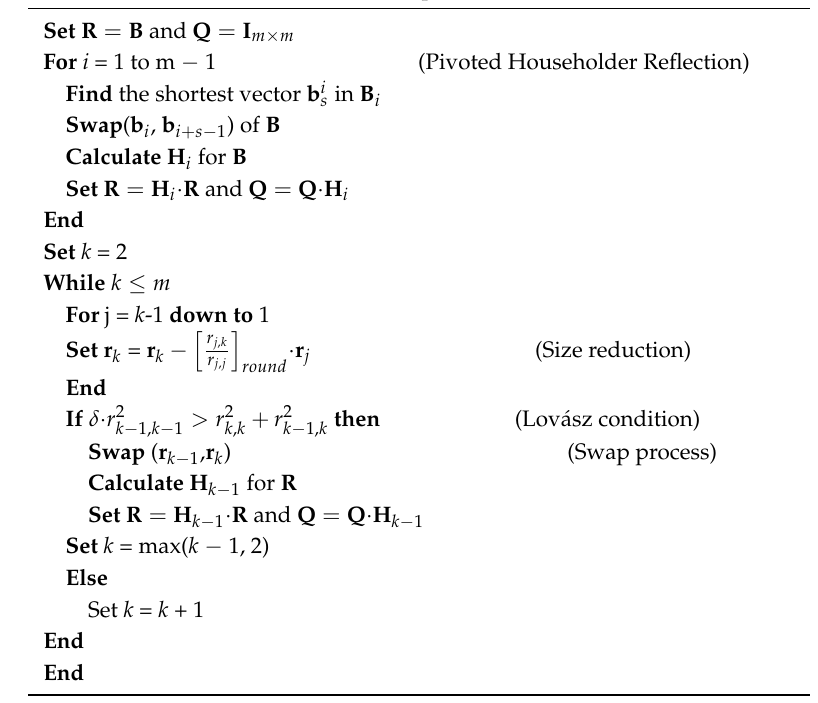
Algorithm 2: The LLL reduction with pivoted